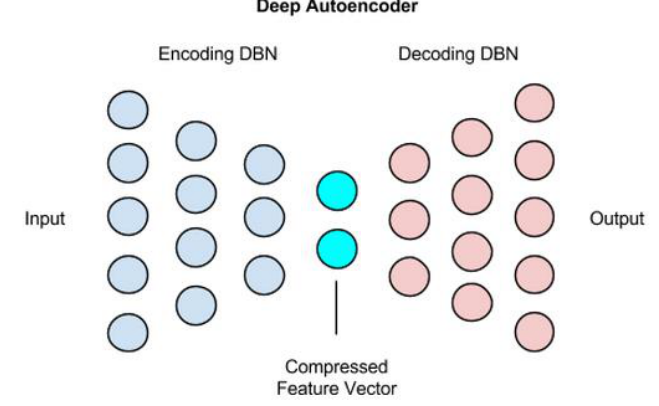
Figure 6. Architecture of a deep auto-encoder. Algorithm 2. Change Detection Using Auto-encoder: